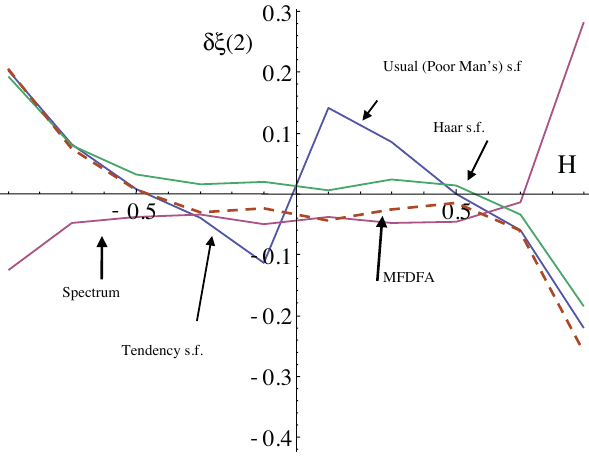
Fig. 5. The compensated spectra for an ensemble of 50 realizations, 2 14 each, α = 1 . 8, C 1 = 0.1, intermittency correction = K( 2 ) = 0.18, with H increasing from top to bottom from − 7 / 10 to 7 / 10, β = 1 + 2 H − K( 2 ) . The dashed horizontal line is the theoretical be- haviour indicated over the range used to estimate the exponent (i.e. the highest and lowest factor of 10 0 . 5 in wavenumber have been dropped). Each curve was offset in the vertical for clarity.